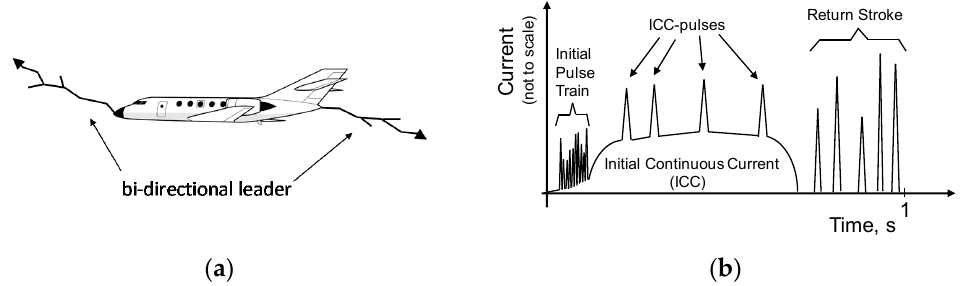
Figure 1. ( a ) Bi-directional leader at the initial phase of the lightning interception; ( b ) Schematic diagram of a typical lightning current waveform (adopted from [6]).